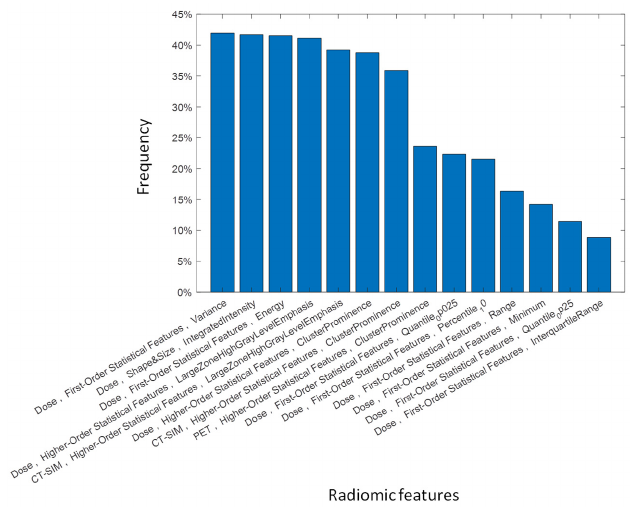
Figure 5. ROC curve of the selected EML model after the 100-times-repeated 10-fold CV.